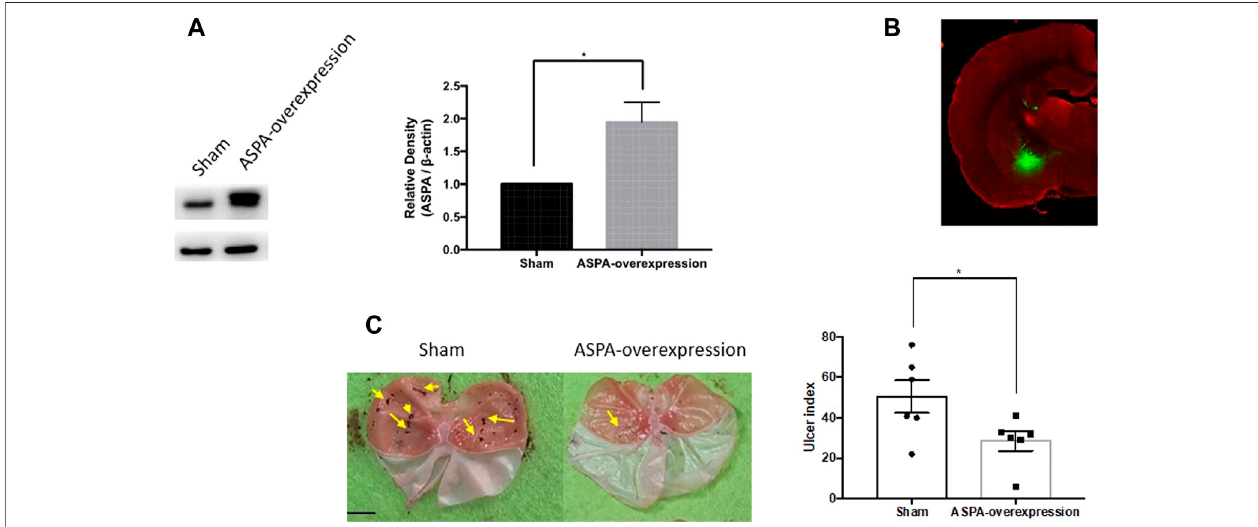
FIGURE4| OverexpressionofNAAhydrolaseASPAinCeAreducedgastriculcercausedbyWIRS. (A) Veri fi cationofinterventionresultsbyWesternblot.( n =3per group). (B) Representative image of injection sites (CeA) in rat brain. (C) Overexpression of ASPA in CeA reduced gastric ulcer caused by water immersion ( n = 6). The arrow indicates the ulcer position. Scar bar, 10 mm. Values are expressed as means ± SEM. *p < 0.05, compared with sham viral group.